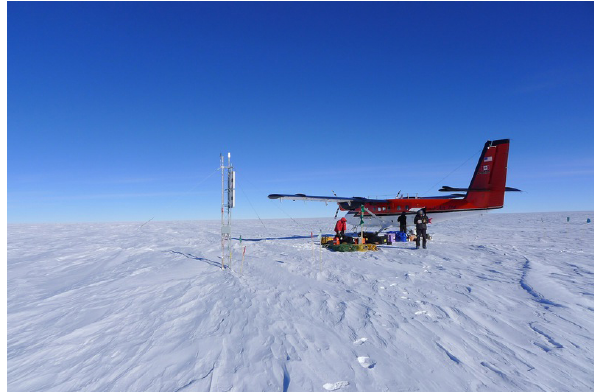
Figure 1. Twin Otter airplane next to the AAL-PIP system at PG2 (84.42 ◦ S, 57.96 ◦ E). The extreme environment and remote nature of the AAL-PIP sites makes in-person maintenance very